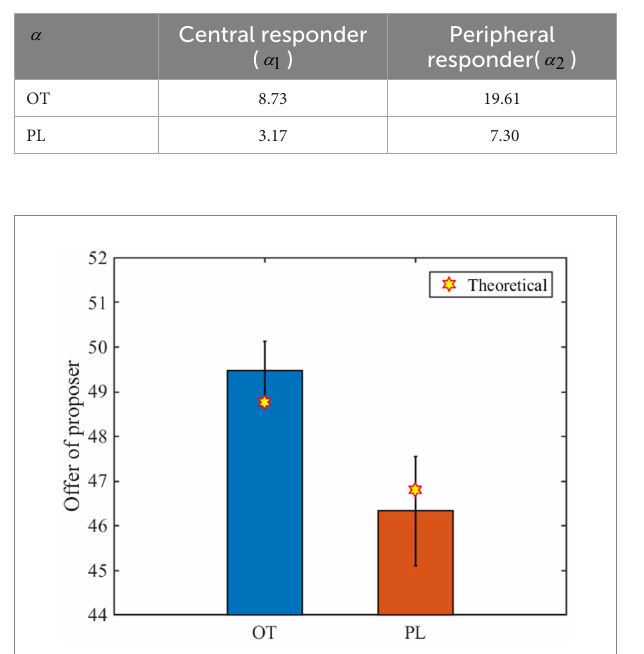
FIGURE 2 Experimental and predicted results of the proposers’ offer. The blue bar and the red bar represent the mean value (all rounds of data) of the proposers’ offer in the OT group and the PL group, respectively. Each error bar represents the standard deviation, and each yellow six-pointed star represents the theoretical